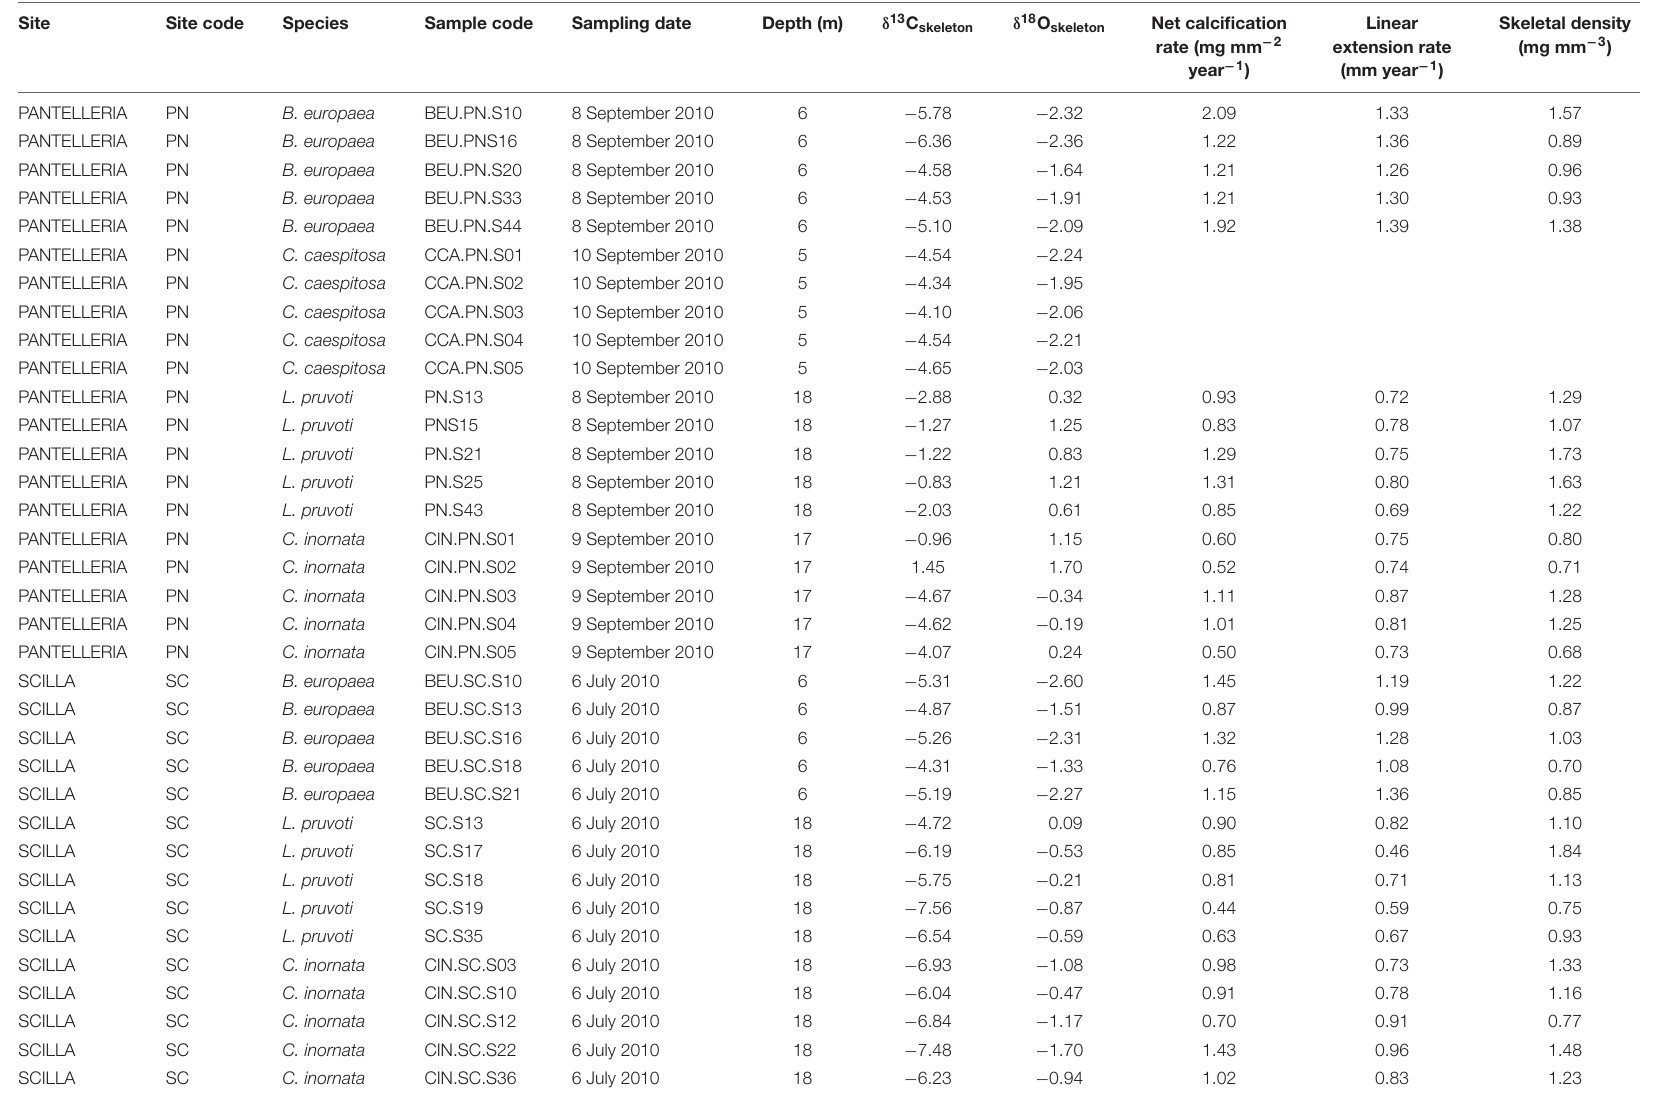
TABLE 4 | Coral aragonite stable isotope data and net calcification rate (mg mm − 2 yr − 1 ), linear extension rate (mm yr − 1 ) and bulk skeletal density (mg mm − 3 ) in Balanophyllia europaea , Leptopsammia pruvoti , and Caryophyllia inornata at 6 sites along the west coast of Italy ( ∼ 850 km transect). Site Site code